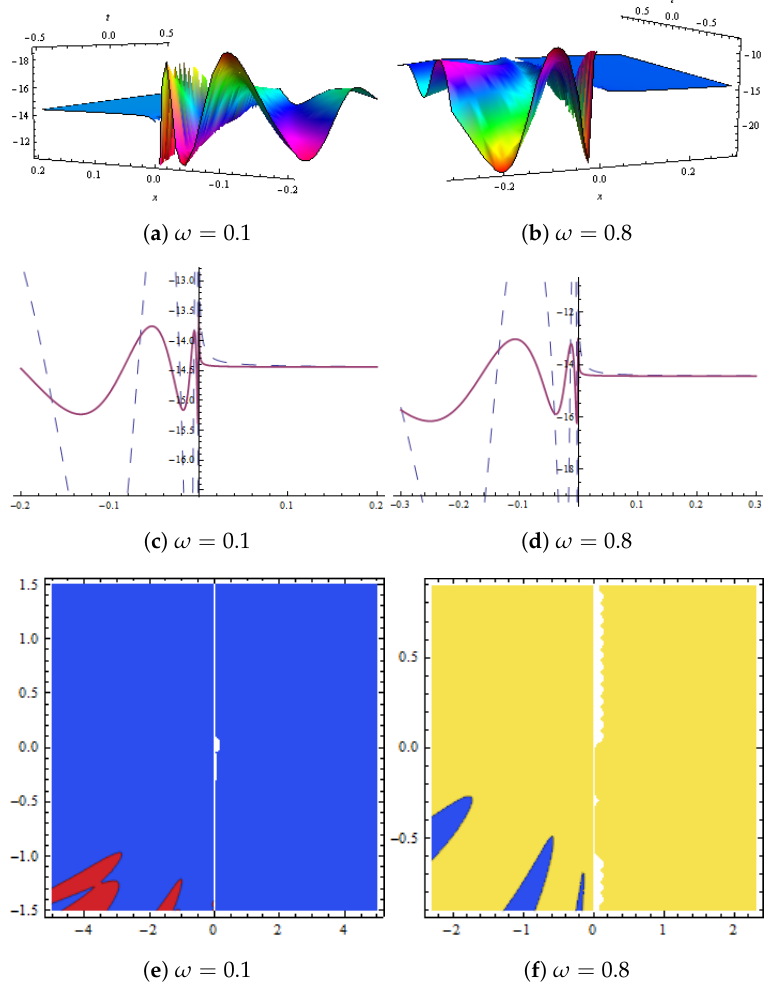
Figure 22. Graphical demonstration of u ( x , t ) in Equation (56) presented with β 1 = 0.3, β 2 = 1.2, β 3 = 0.5, ζ = 0, l 1 = − 1.8, l 2 = 0.05, l 4 = 0.01, Q = 5.2, r 1 = 2.5, r 2 = 1.3, w 2 = 0.1, w 3 = 3, w 4 = 1.9, w 5 = 1.2 and φ = 1.4. ( a , b ) show 3D graph, ( c , d ) represent 2D graph and ( e , f ) show contour plot.